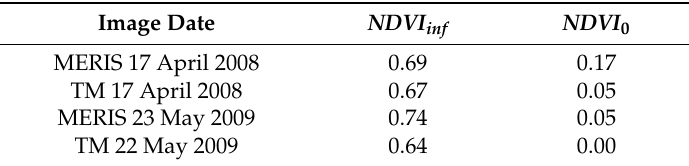
Table 3. Mean values of NDVI inf and NDVI 0 calculated respectively as percentiles 99.5 and 0.5 of NDVI distribution within the study area.